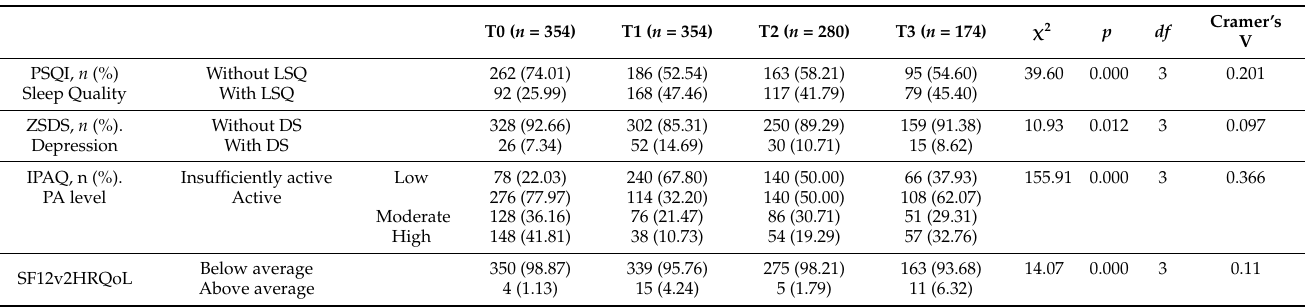
Table 3. Differences between measurement times for sleep quality, depression and PA level (di- chotomized